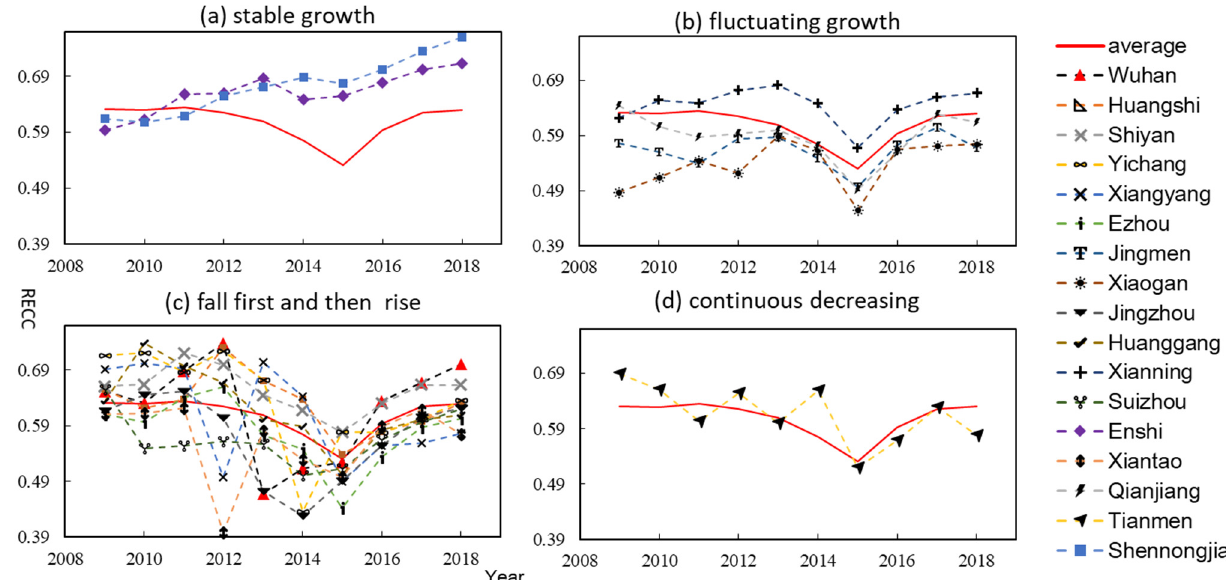
Int. J. Environ. Res. Public Health 2021 , 18 , x FOR PEER REVIEW Figure 3. Trend of RECC in Hubei Province during 2009–2018: ( a ) the stable growth of RECC; ( b ) the fluctuating growth of RECC; ( c ) the RECC fall first and then rise; ( d ) the continuous decreasing of RECC.